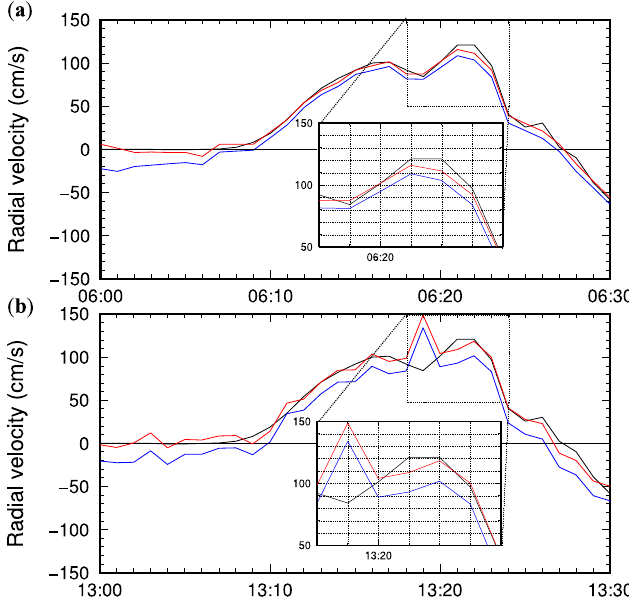
Figure 3. Comparison of temporal variations of simulated radial tsunami velocity ( v tsu ( 04,10, t ) ; black line) and extracted tsunami velocities at range cell 10 on beam 04 by the present method ( v (cid:48) vt ( 04,10, t ) ; red line) and by the Fuji and Hinata (FH) method (blue line) for scenarios in which the tsunami occurred at ( a ) 06:00 on 1 February 2014 and ( b ) 13:00 on 27 February 2014.